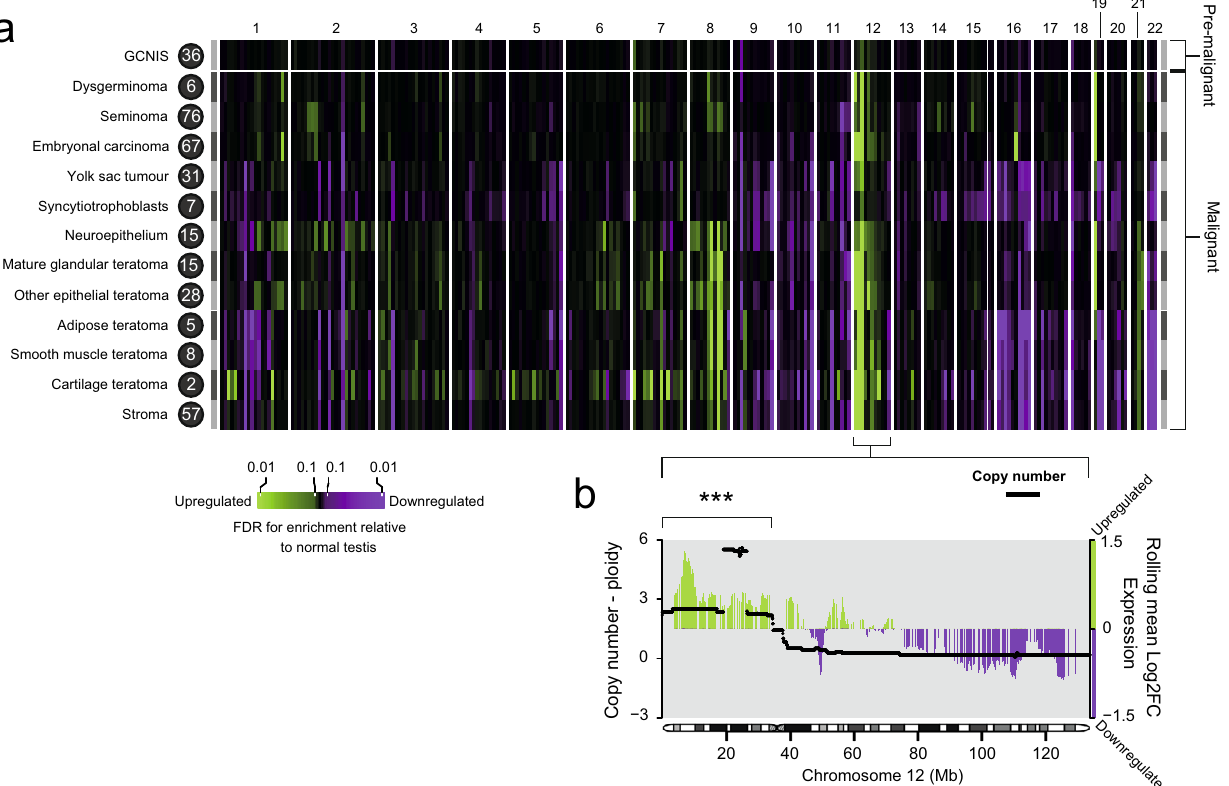
Fig. 4 The relationship between GCT genome and transcriptome. a Heatmap showing gene enrichment per GCT tissue relative to healthy seminiferous tubules, binned by cytoband. Colours correspond to signi fi cance of enrichment according to the adjusted p -value (false discovery rate correction). The number next to each histology is the number of eligible microbiopsies that informs the analysis (Supplementary Data 16). b Combined plot of the chromosome 12 copy number changes across all invasive tumours and the rolling average log2 fold-change in gene expression compared with healthy seminiferous tubules. The window size for the rolling average is 50 genes. The average log2 fold-change in expression across 12p was signi fi cantly higher than across comparable numbers of genes found across regions with near baseline ploidy (one-sided permutation test, p < 1 × 10 − 5 ) (Supplementary Fig. 9), as indicated by the three asterisks. Source data are provided as a Source Data fi